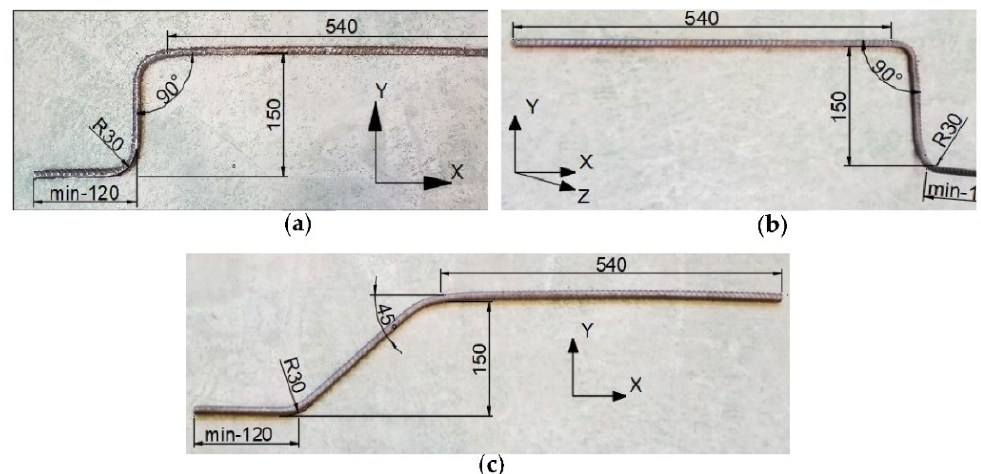
Figure 3. Connection bar details (size 10 M): ( a ) 90-degree bends for end bearing connection, ( b ) 90-degree bends for side bearing connection, and ( c ) 45-degree bends for end bearing connection (Dimensions in mm).